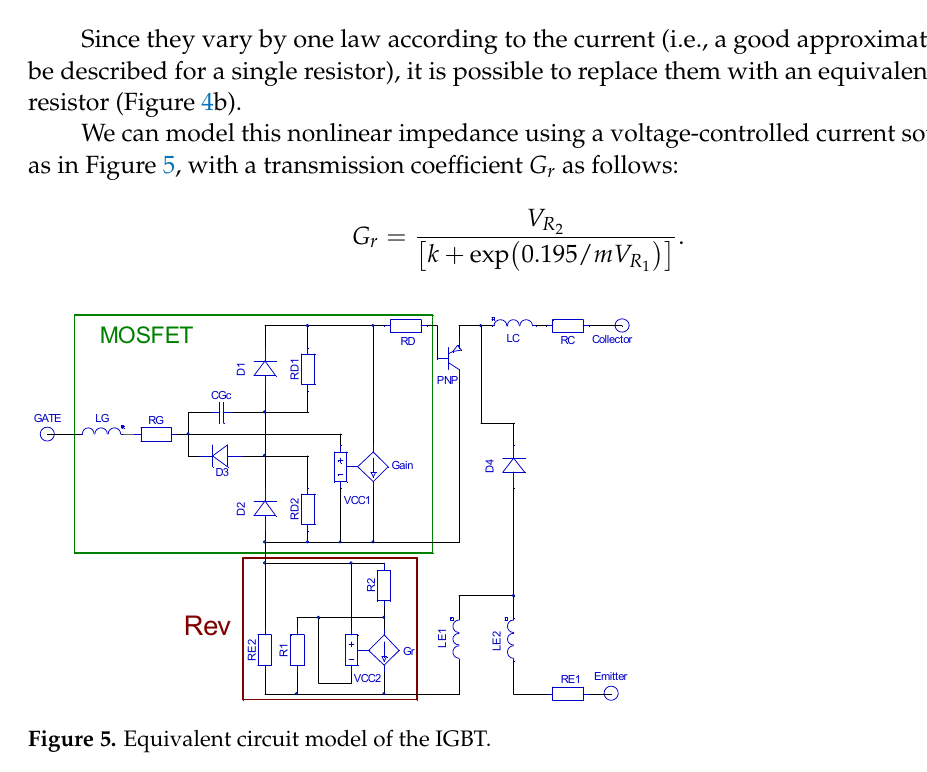
Figure 4. Updated general circuit of the IGBT negative feedback resistor connection schematic in the IGBT ( a , b ) simple versions of this connection.